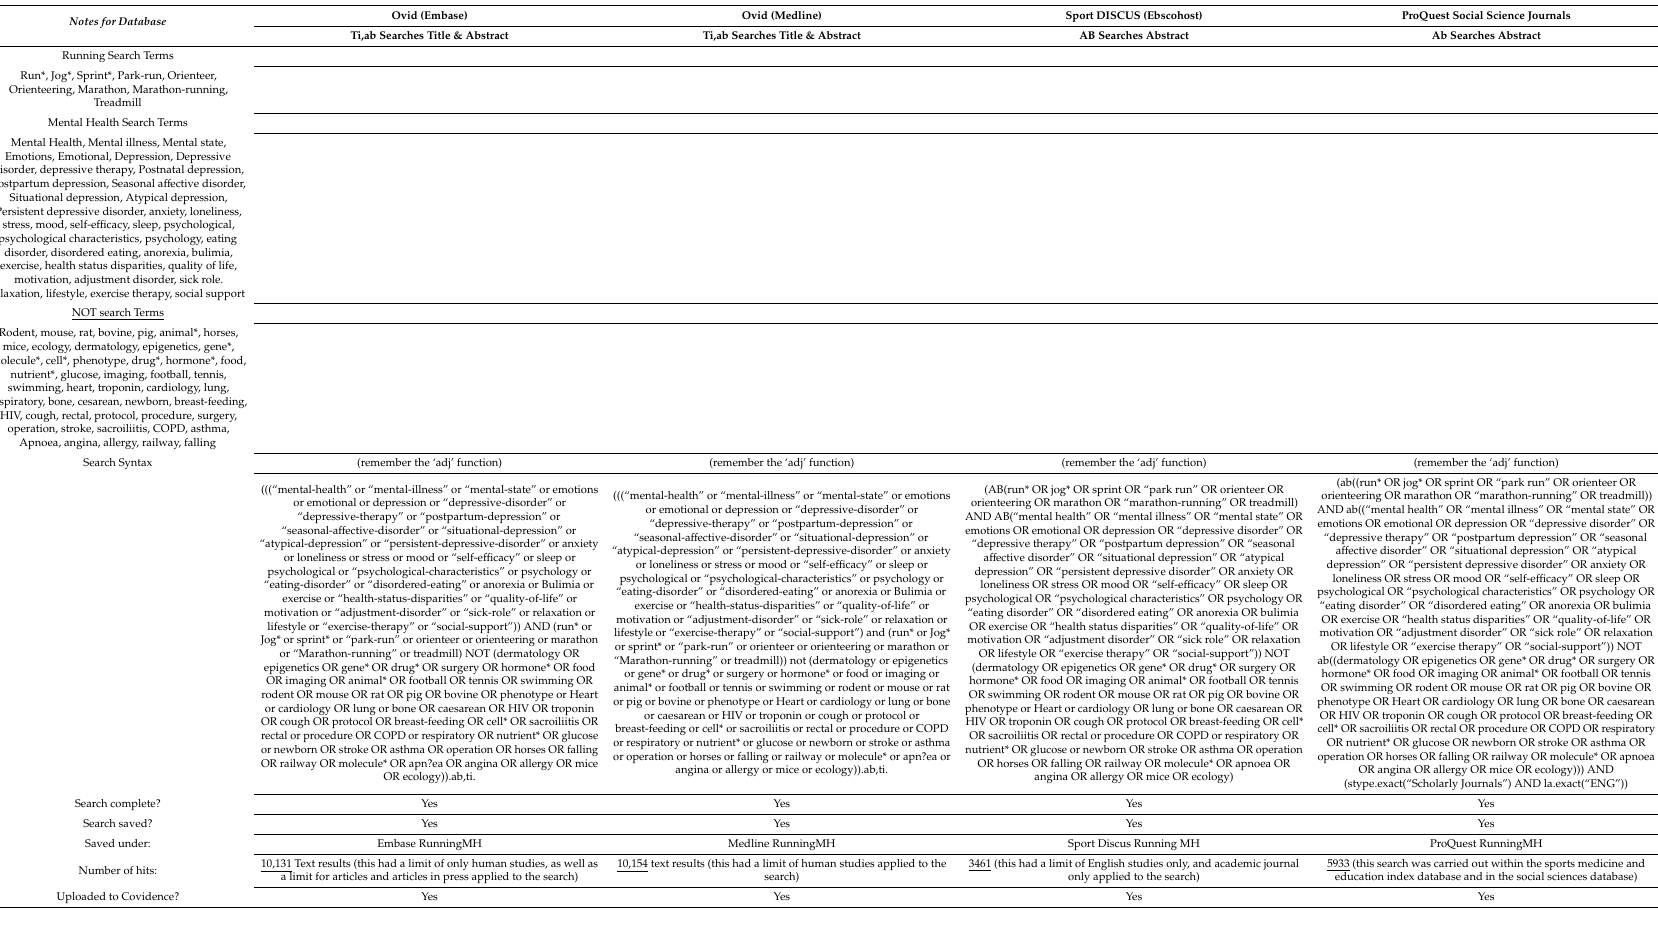
Table A2. Details of the search strategy used in all 4